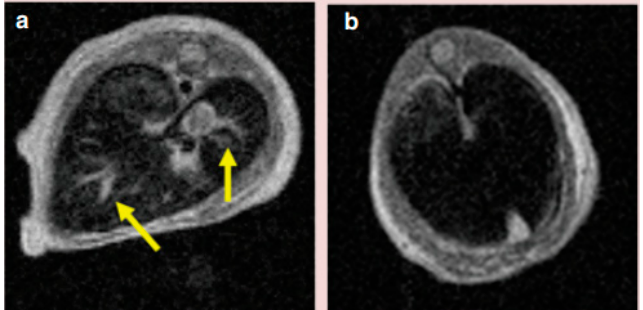
Figure 5. T 2 -weighted axial MRI pictures illustrating a mice liver cross section 60 min postadministration of ( a ) raspberry SPIONs; ( b ) commercially available contrast agent Ferucarbotran ® . The arrows in ( a ) show hepatic liver vessels, that are not observed in ( b ). Reprinted from Hobson, N.J.; Weng, X.; Siow, B.; Veiga, C.; Ashford, M.; Thanh, N.T.; Schätzlein, A.G.; Uchegbu, I.F. “Clustering superparamagnetic iron oxide nanoparticles produces organ-targeted high-contrast magnetic resonance images.” Nanomedicine 14 (2019)